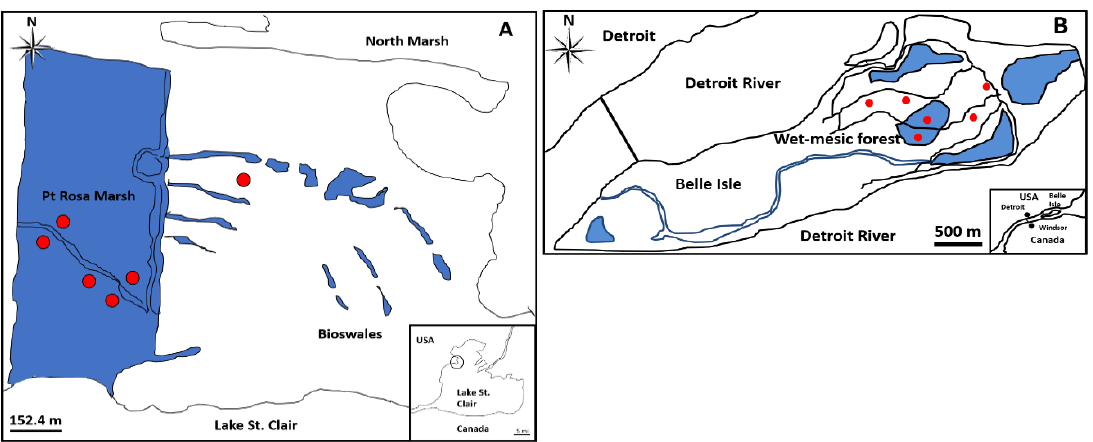
Figure 1. Maps of deployment sites (red markers) of mesocosm buckets. ( A ) Lake St. Clair Metropark; ( B ) Belle Isle State Park.